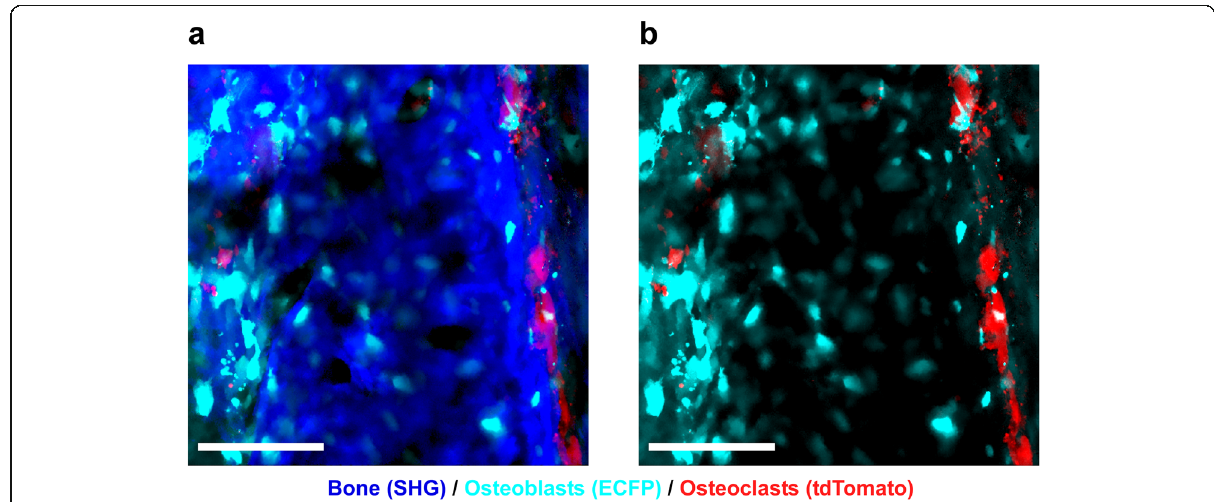
Fig. 4 Representative intravital two-photon microscopy images of ectopic bone formation area in Col2.3-ECFP/TRAP tdTomato mice. Visualization of osteoblasts, osteoclasts, and newly formed bone (collagen) after implantation of a collagen sponge containing BMP-2 [15]. Cyan, osteoblasts expressing Col2.3-ECFP; red, osteoclasts expressing TRAP-tdTomato; blue, collagen fibers (second harmonic generation, SHG). Scale bar, 100 μ m